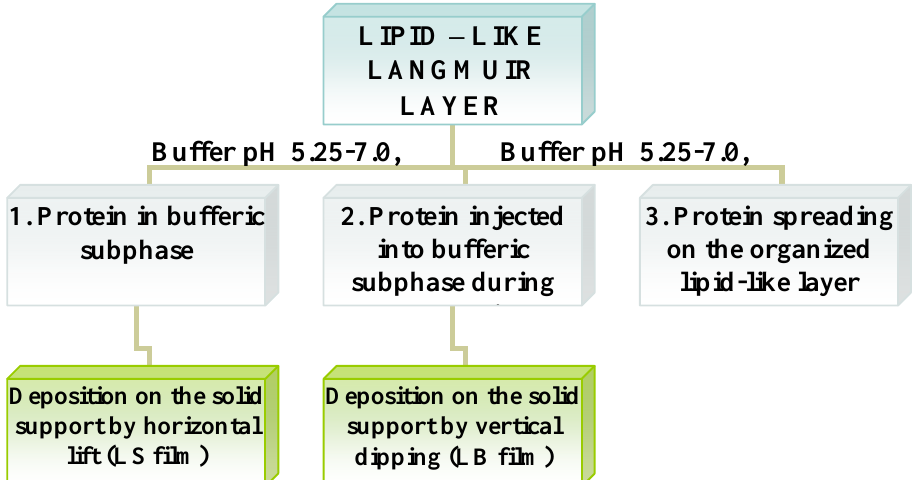
Figure 3. Approaches to form protein LB/LS